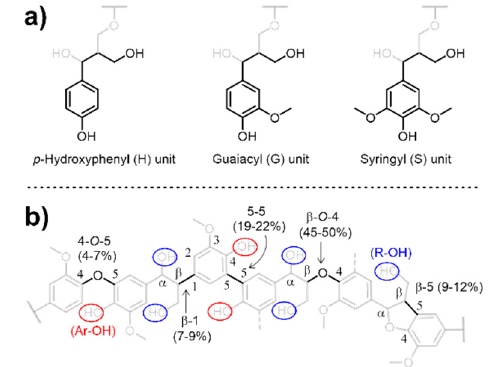
Scheme 1. Structural representation of ( a ) aromatic repeating units and ( b ) dominant ether and carbon–carbon linkages in lignin with R-OH and Ar-OH groups.